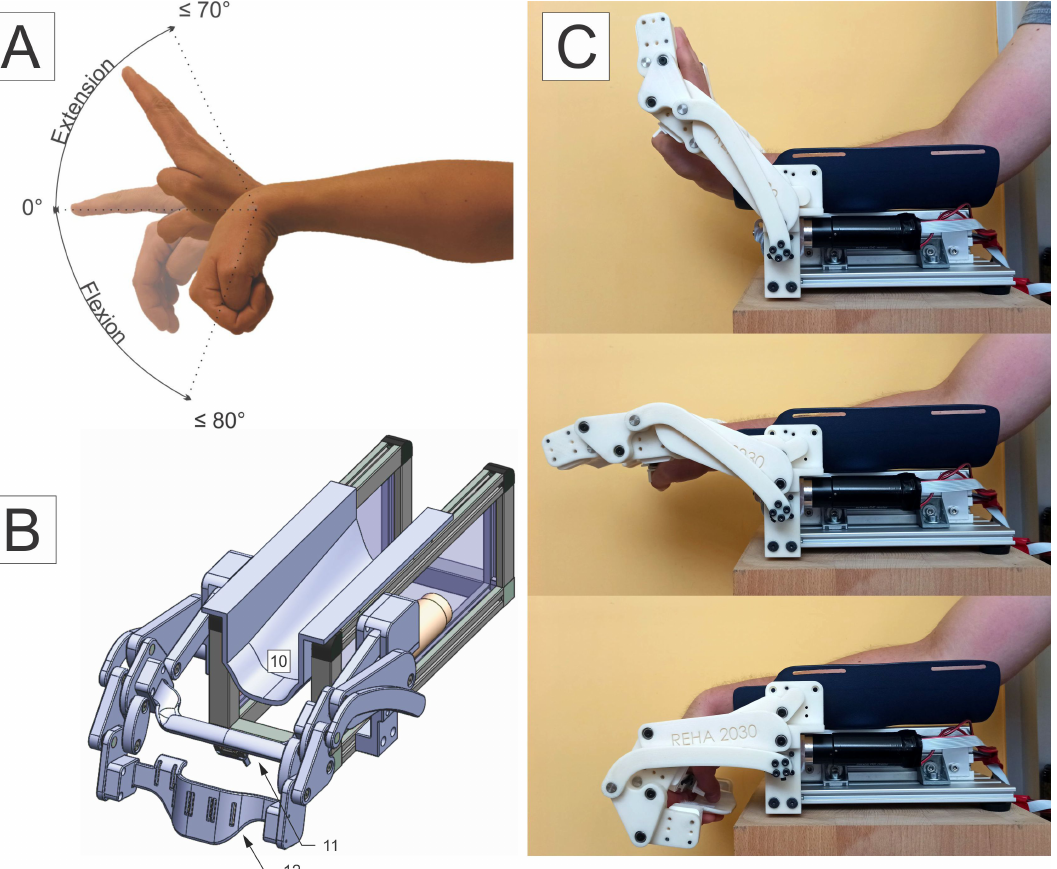
Figure 2. The desired movement ( A ), 3D model with supportive parts of the device marked— 10: forearm support, 11: proximal finger rest, and 12: distal finger rest ( B ), and the actual device, moving through its available ROM ( C